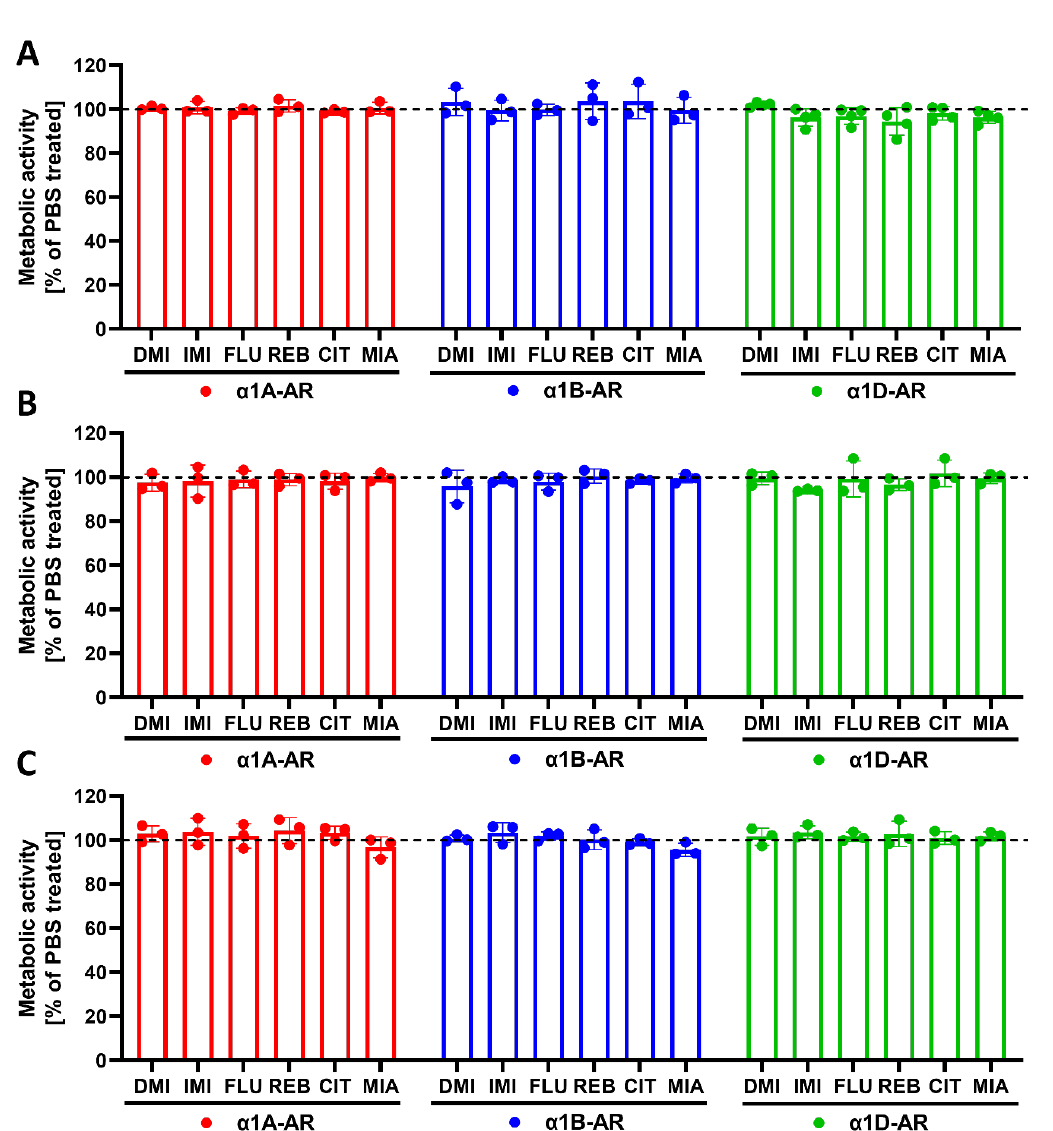
Figure 7. Effects of incubation with the chosen antidepressants on the metabolic activity of cells expressing the α1A - , α1B - or α1D - adrenergic receptor subtypes. The cells were incubated with the chosen antidepressants for 30 min ( A ), 24 h ( B ) or 120 h ( C ). IMI — imipramine; DMI — desipramine; MIA — mianserin; REB — reboxetine; CIT — citalopram; FLU — fluoxetine or PBS (dashed line). Data are shown as the mean ± SD; n = 3 – 4 independent experiments.